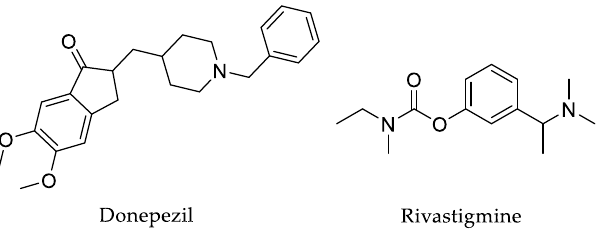
Figure 1. Chemical structures of Alzheimer’s disease drugs: donepezil and rivastigmin.